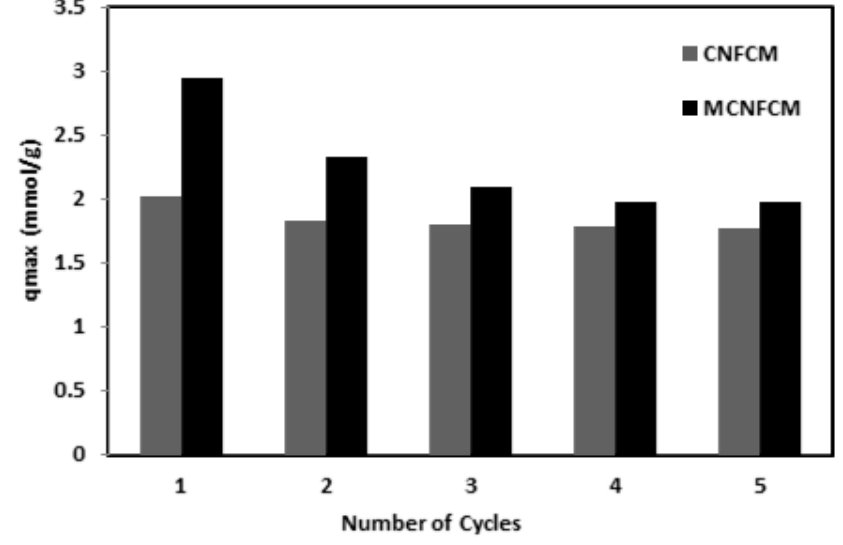
Figure 16. Cyclic adsorption of CO 2 of CNFCM and MCNCM (40% CO 2 , T = 30 °C, P = 1 Bar).